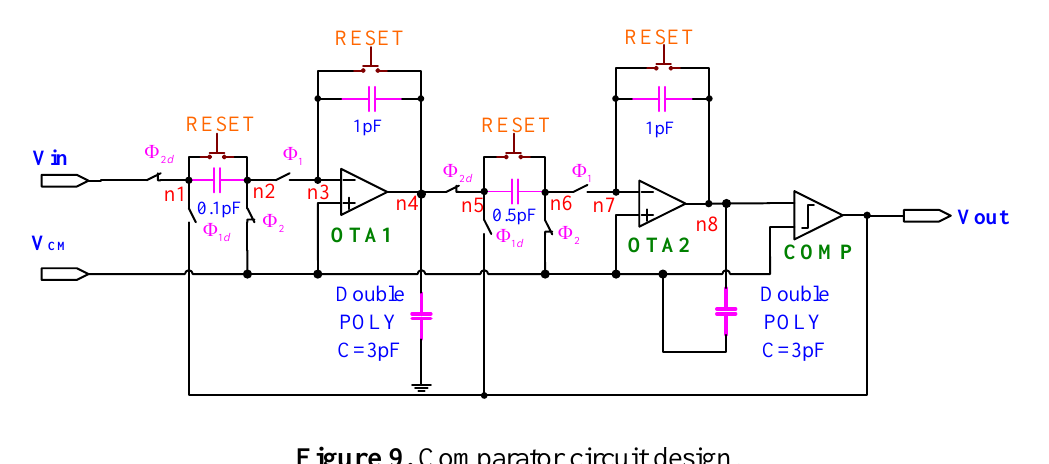
Figure 9. Comparator circuit